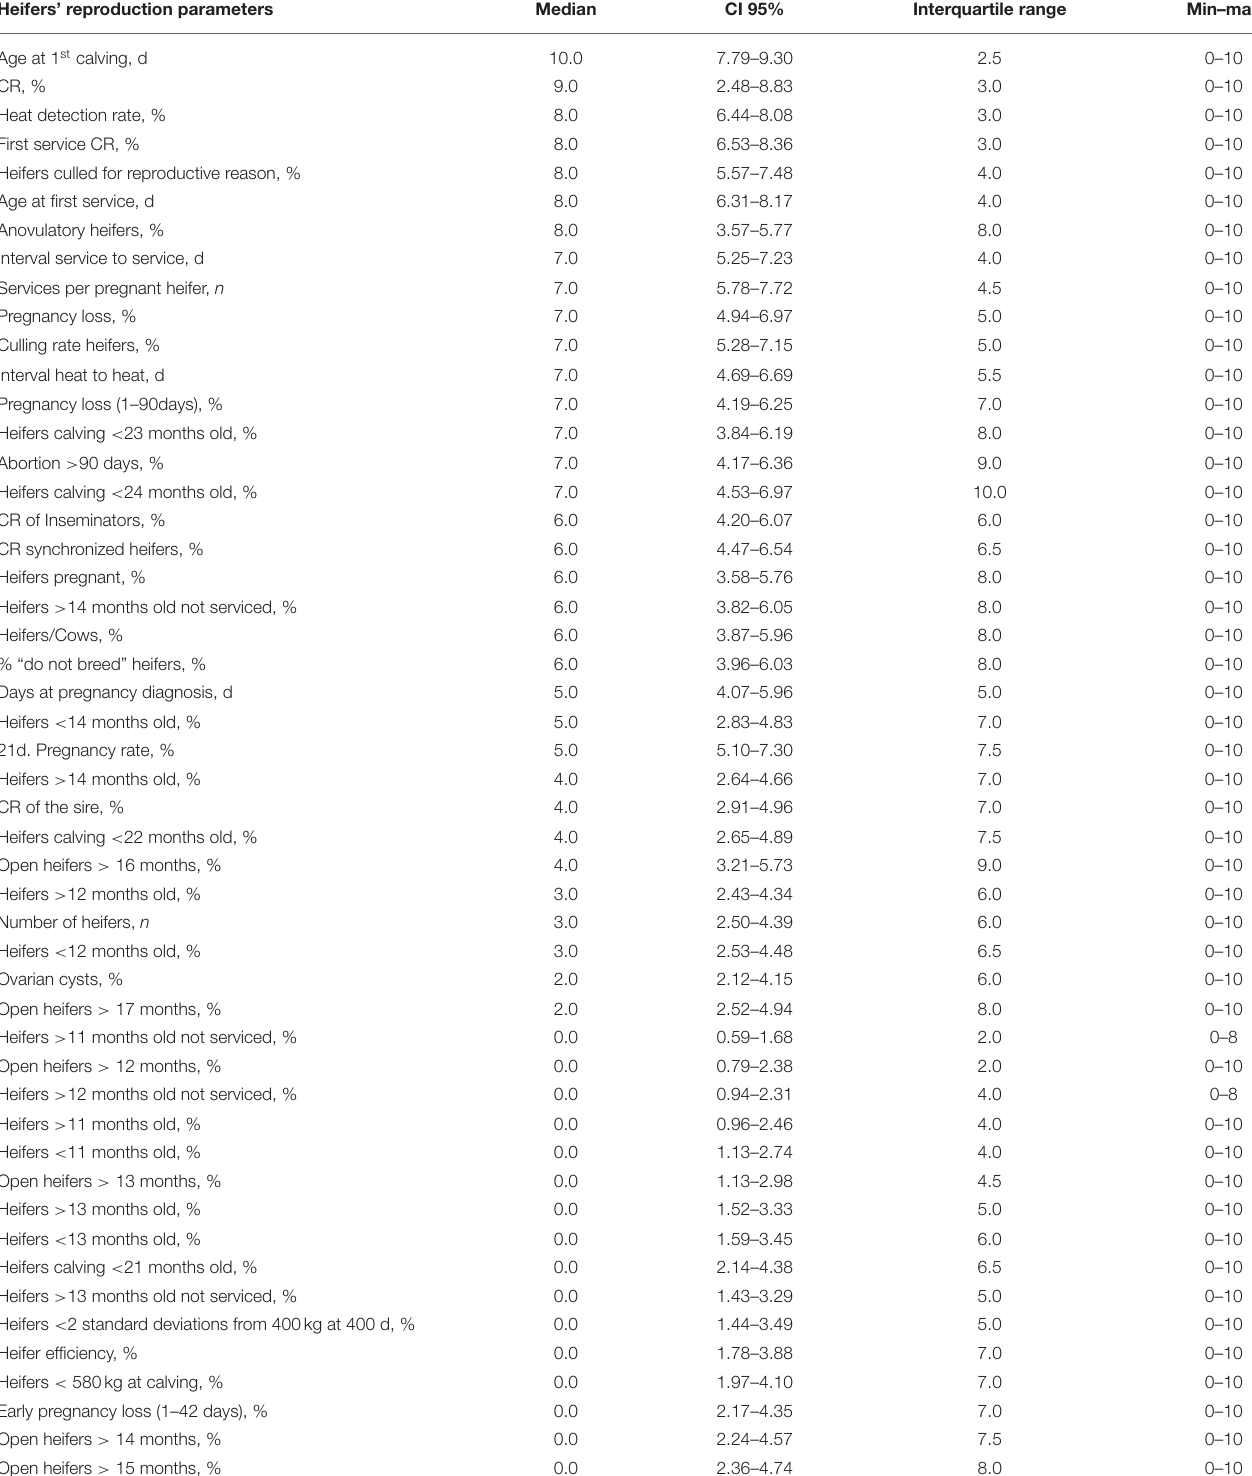
TABLE 6 | Answers given by consultants on Section 5: Heifers’ Reproduction parameters, where 0 is of minimal or irrelevant importance and 10 represents the maximum importance. Heifers’ reproduction